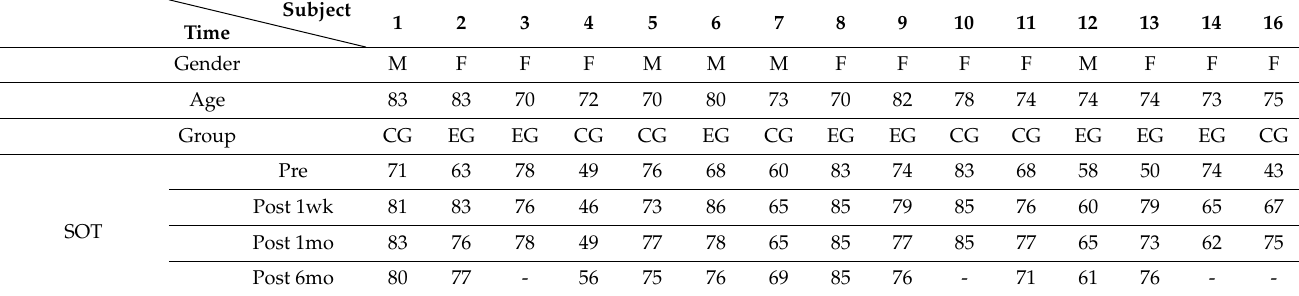
Table A1. Clinical balance testing